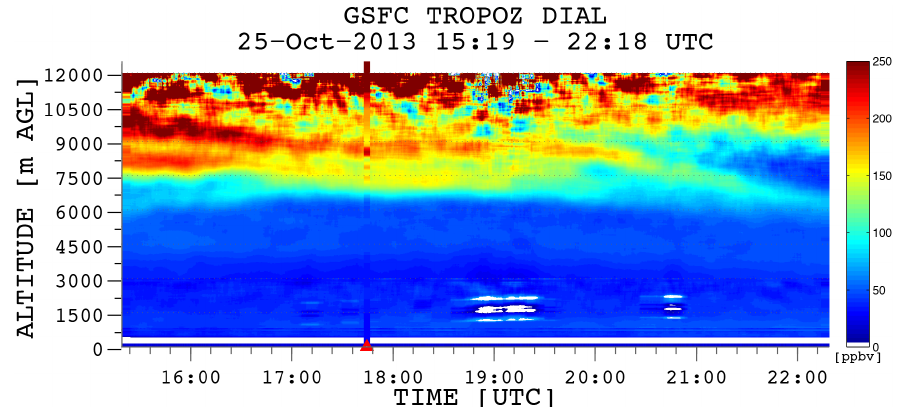
Figure 9a. Time series plot of the ozone mixing ratio [ppbv] from the GSFC TROPOZ DIAL between 15:19 and 22:18UTC (11:19– 18:18EDT) at a 10min temporal resolution, with the colocated ozonesonde launch corresponding to the red arrow point at 17:44UTC. The surface ozone monitor mixing ratios (1min resolution) are plotted in the lowest bin of the figure.